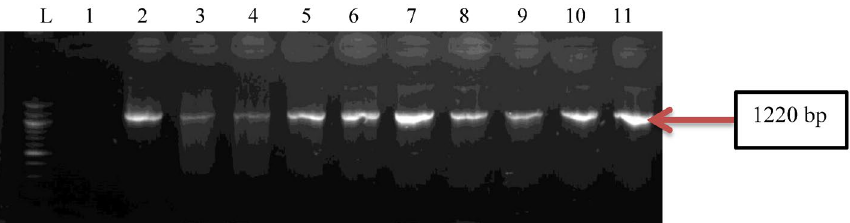
Figure 5. Gel electrophoresis of PCR products of lasB gene among P. aeruginosa representatives isolates recovered from HWW effluent. Lane 1: DNA marker (100 bp). Lane 2–11: positive isolates of lasB gene (1220